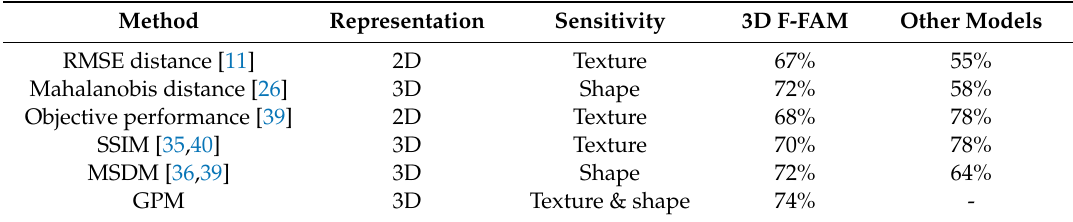
Table 5. Comparison of notable performance evaluation metrics used in facial aging